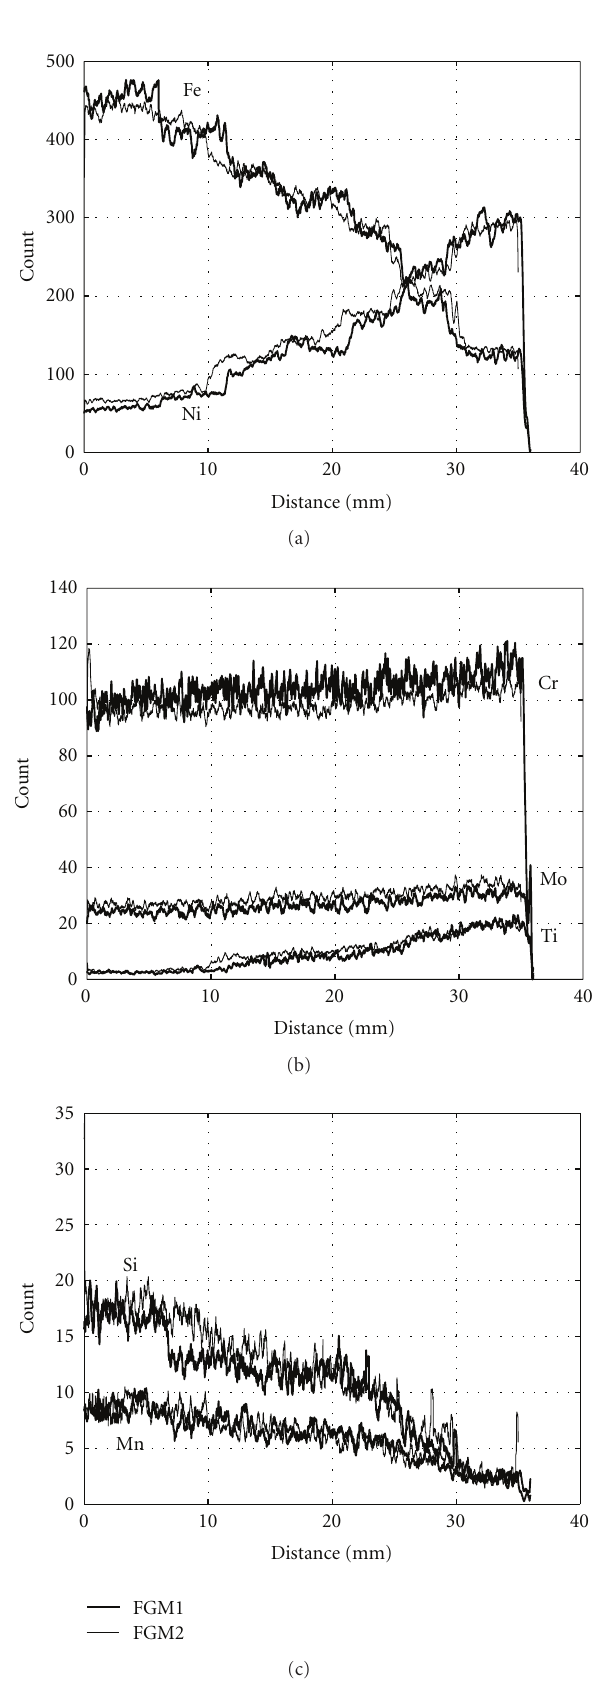
Figure 4: The compositional distribution.